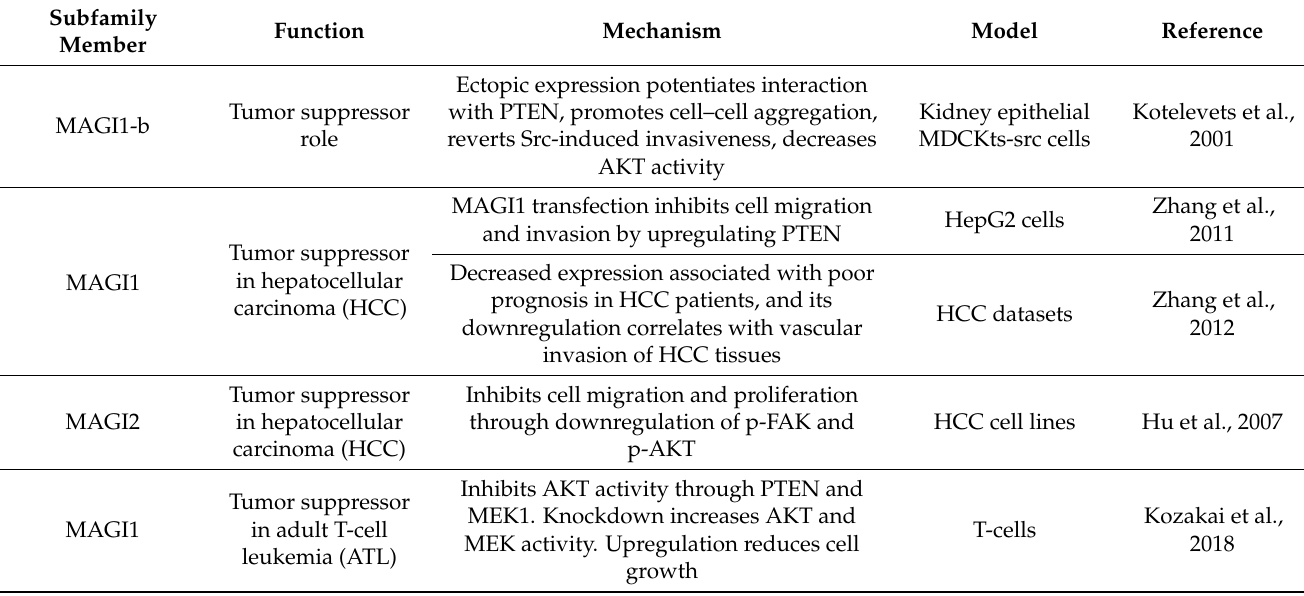
Table 1. Summary of the tumor suppressor functions of MAGI in different